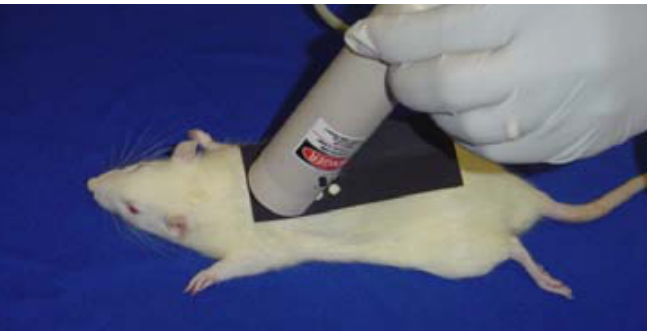
FIGURE 4 - Positioning of the animal, template and probe for laser